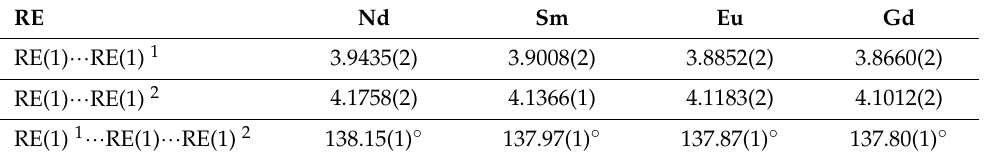
Table 6. Interatomic RE ··· RE distances [Å] and angles in the RE(OAc) 3 · 2AcOH structure type.